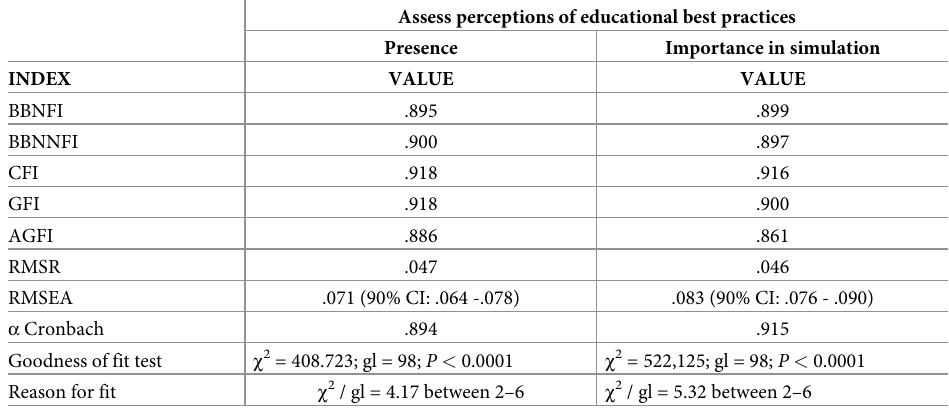
Table 3. Indices of goodness of fit of the confirmatory model.